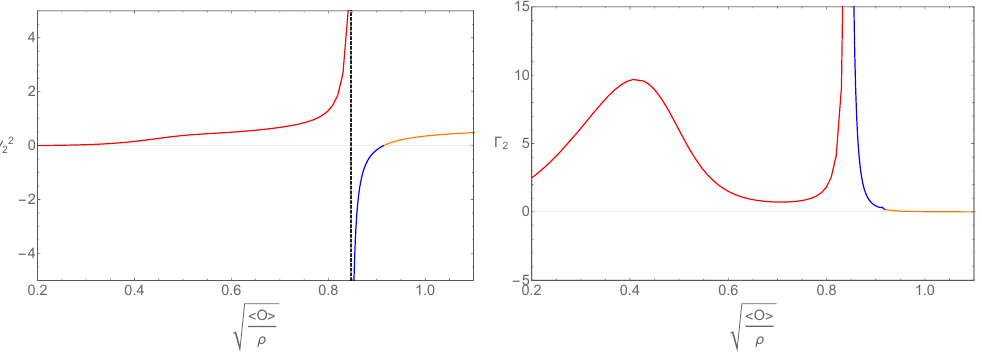
, Γ 2 of second sound across the whole phase 2